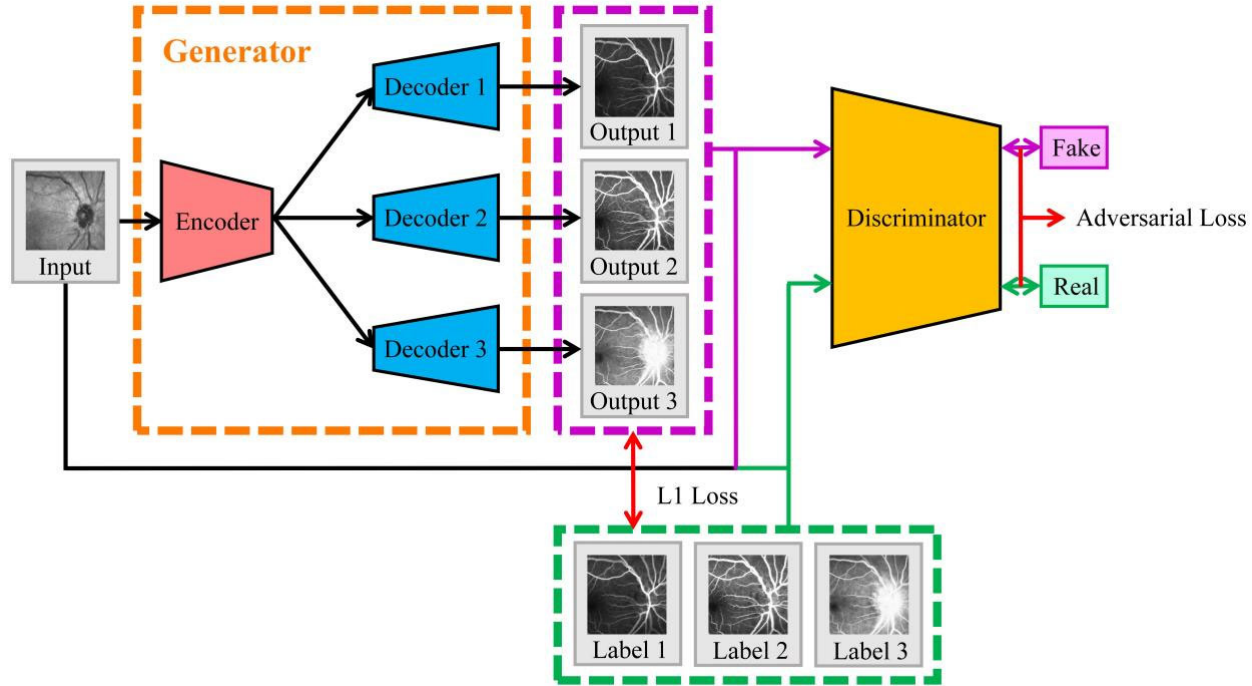
Figure 1. Diagram of our SPFSAT algorithm.